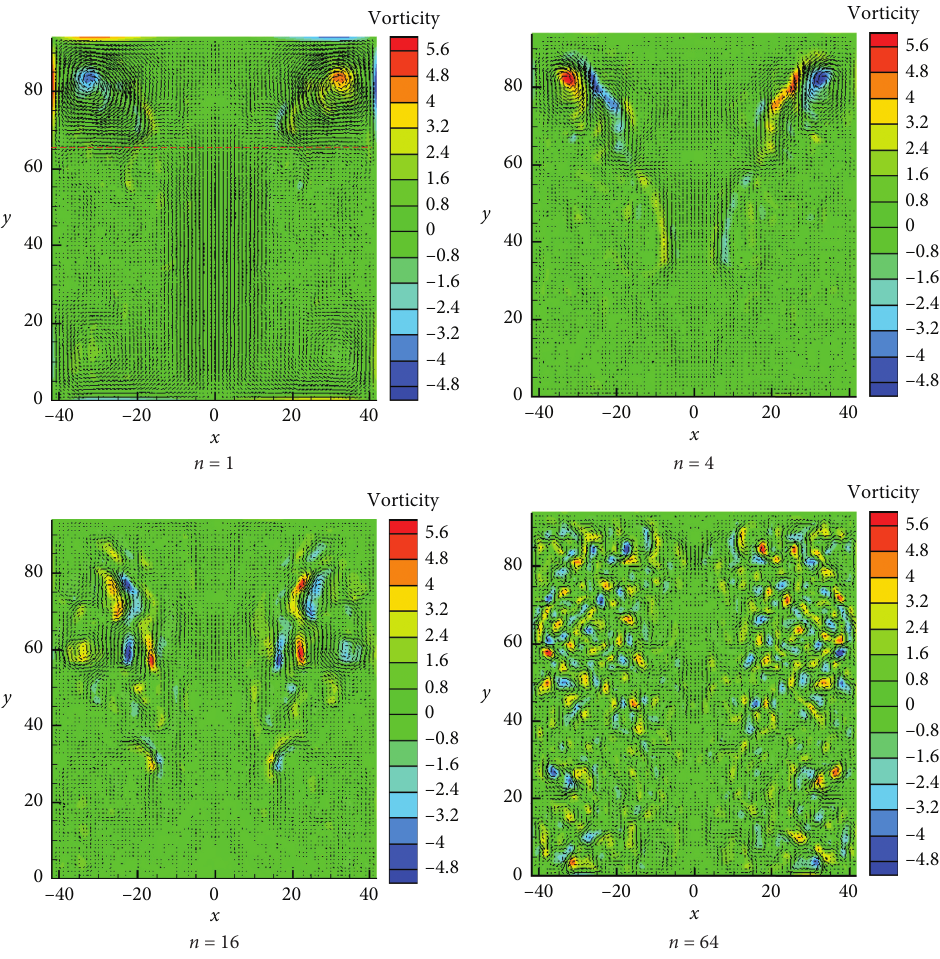
Figure 10: The single POD mode at 40g oscillation acceleration under 70% fill